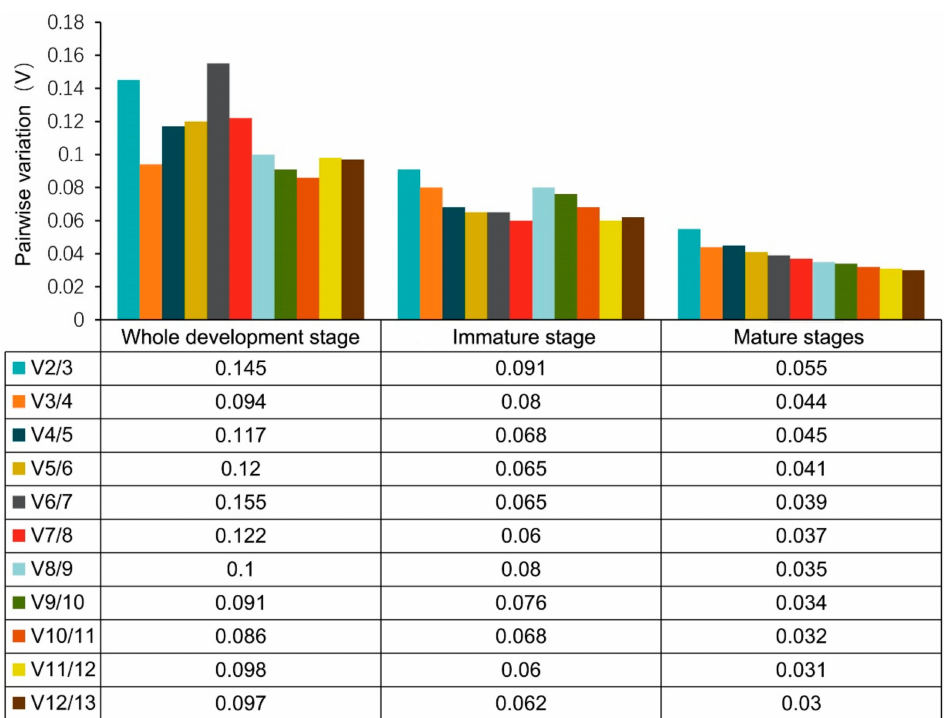
Figure 2. Pairwise variation (V) analyses of the candidate RGs in immature, mature, and whole development stage. GeNorm program calculates the pairwise variation (Vn / n + 1) to determine the e ff ect of additional RG on accurate normalization. The cuto ff threshold was proposed to be 0.15, below which the inclusion of an additional RG is not